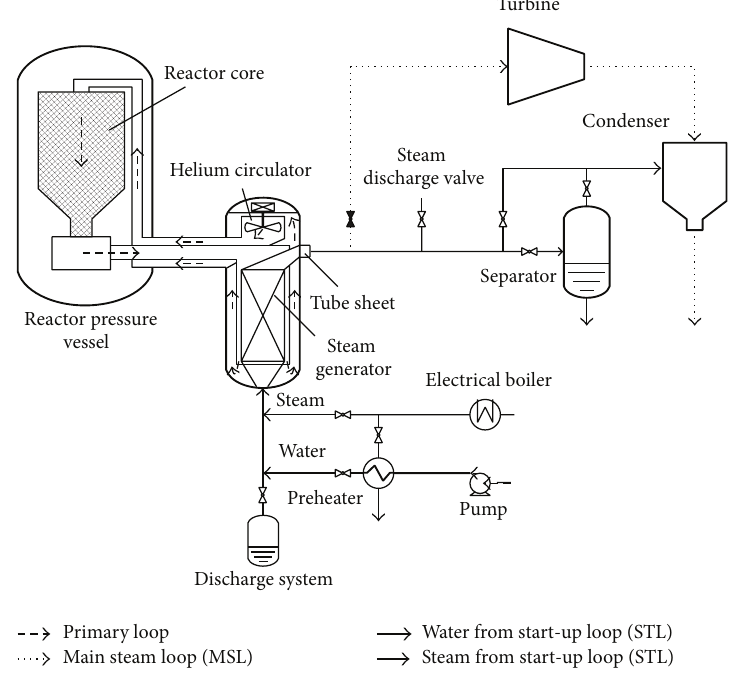
Figure 1: Schematic of flow diagram of